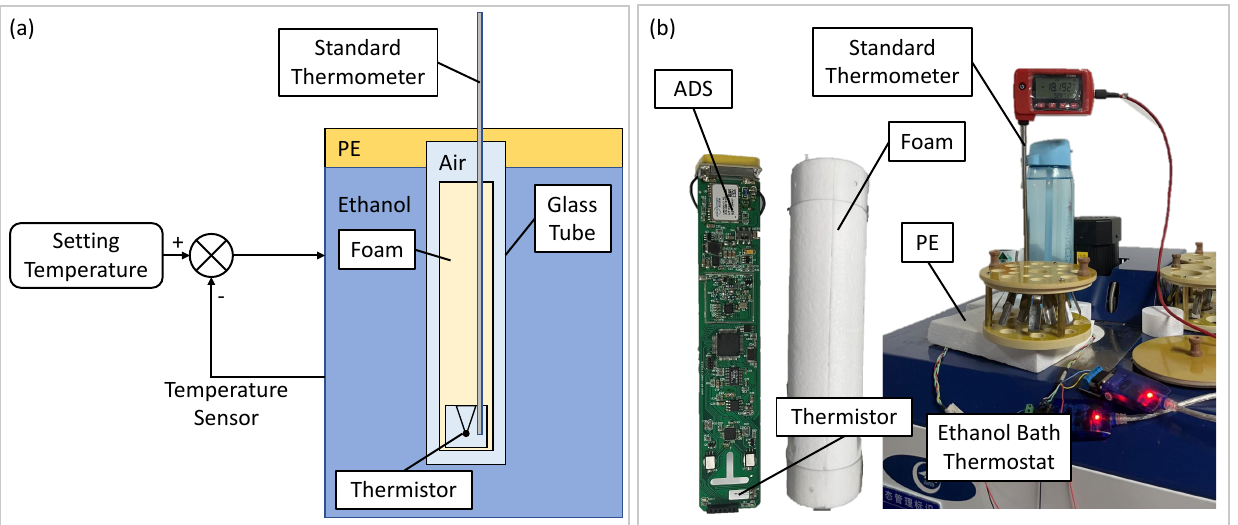
Figure 1. ( a ) Temperature sensor calibration system for ADS, mainly including ADS, thermostat, glass tube, fixed fixture, and standard thermometer. ( b ) The physical photo of the temperature sensor calibration system for